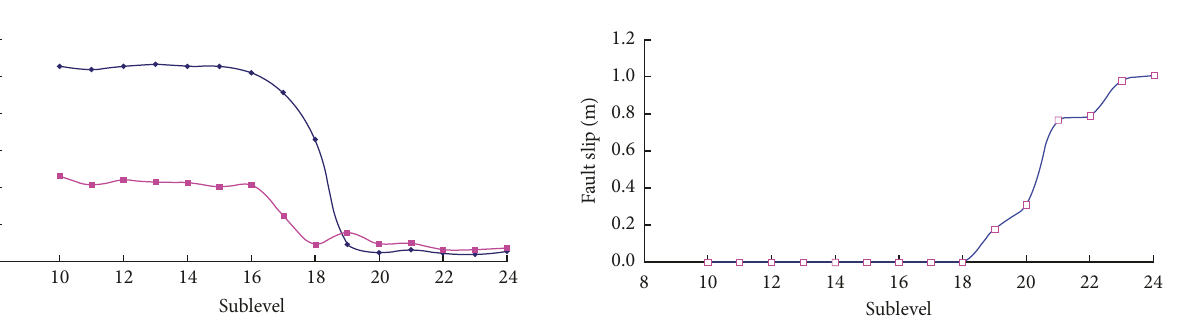
Figure 15: Relationship of slip amount of fault F4 with mining depth.